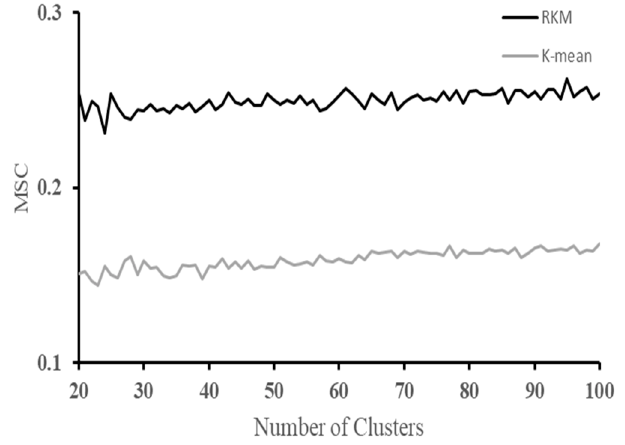
Figure 5. Chart of the Mean of Silhouette Coefficient of RKM and K-mean.